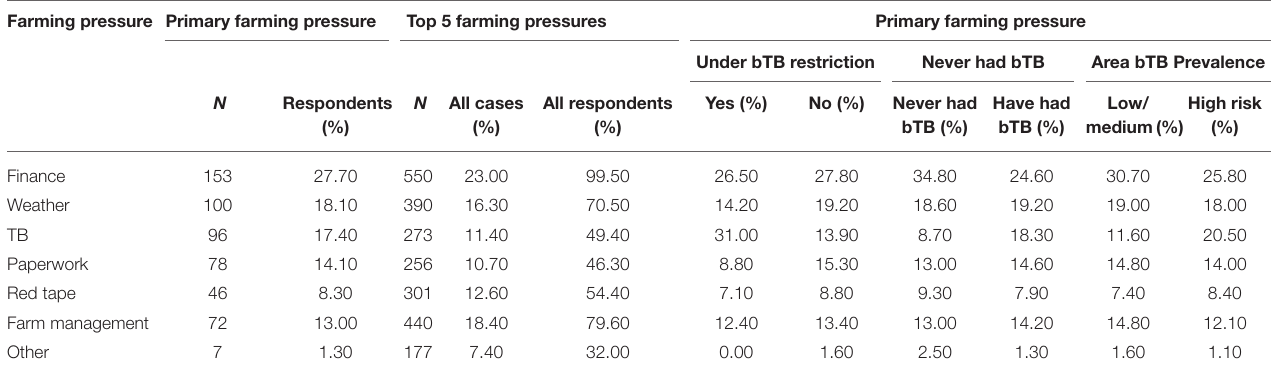
TABLE 4 | Farming Pressures cited as most significant by surveyed